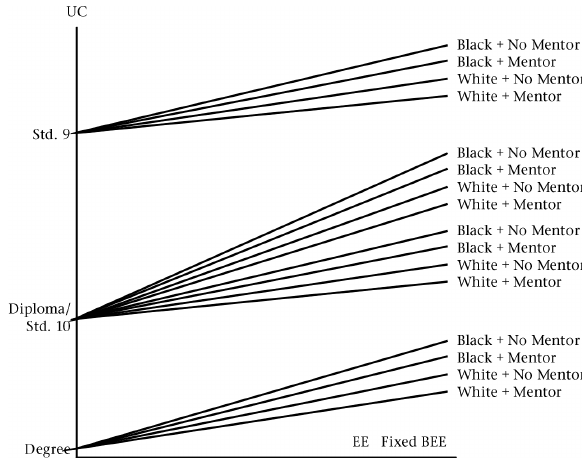
Figure 11: A graphical representation of the predictors of Union